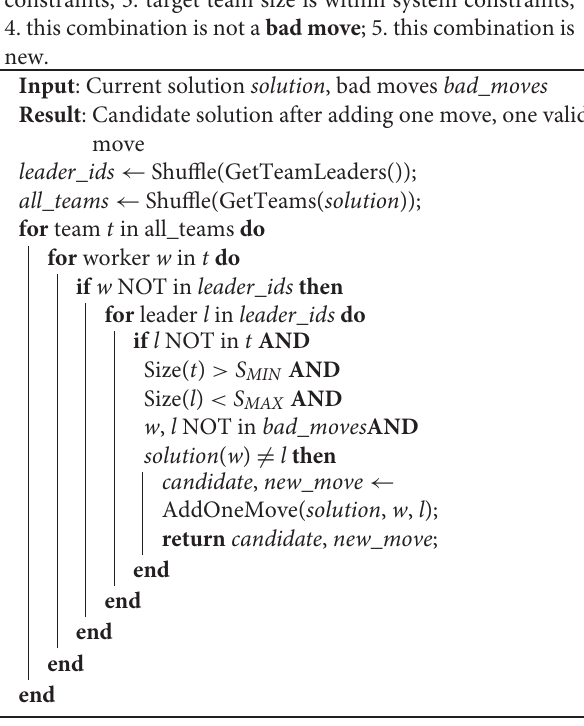
Algorithm 2: Add valid move algorithm . This algorithm loops for every team and for every worker (that are not team leaders), until it finds a worker and a team (represented by its leader) to meet the following five conditions: 1. the